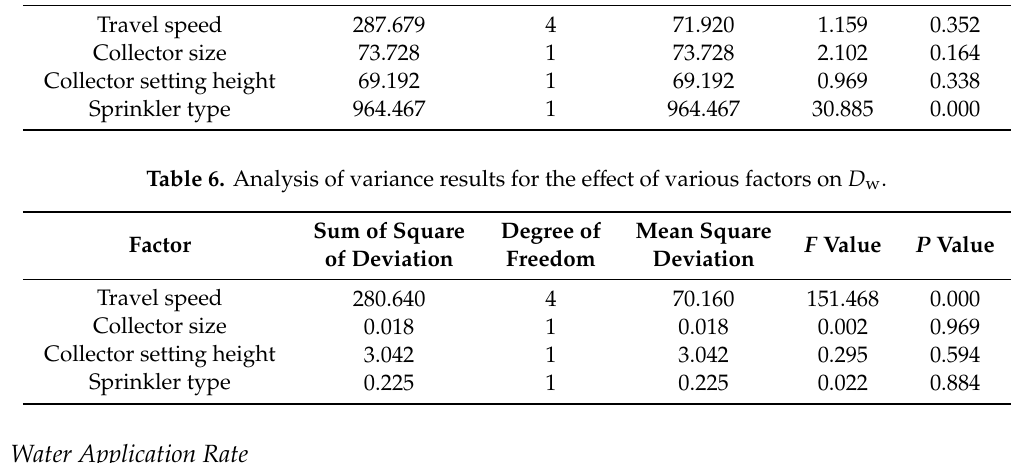
Table 5. Analysis of variance results for the e ff ect of various factors on CU H . Factor